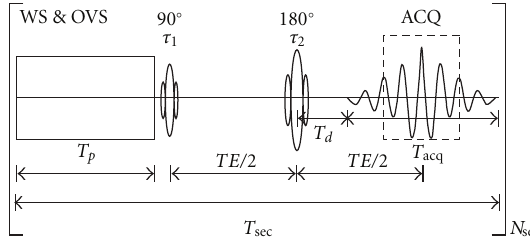
Figure 1: Pulse sequence diagram and timing for multi-section MRSI. The T p is the time for the preparation period, which includes water suppression and outer volume suppression; τ 1 and τ 2 are the durations of 90 ◦ and 180 ◦ pulses, respectively; TE is the spin echo time; T d is the time delay before data acquisition, which is used for slice selection in the z -direction and phase encoding in the x - y plane of the slice (not shown); T acq is the acquisition time; T sec is the time for one slice, and the total repetition time TR for N sec slices is T R = T sec × N sec . WS: water suppression; OVS: outer volume suppression; ACQ: